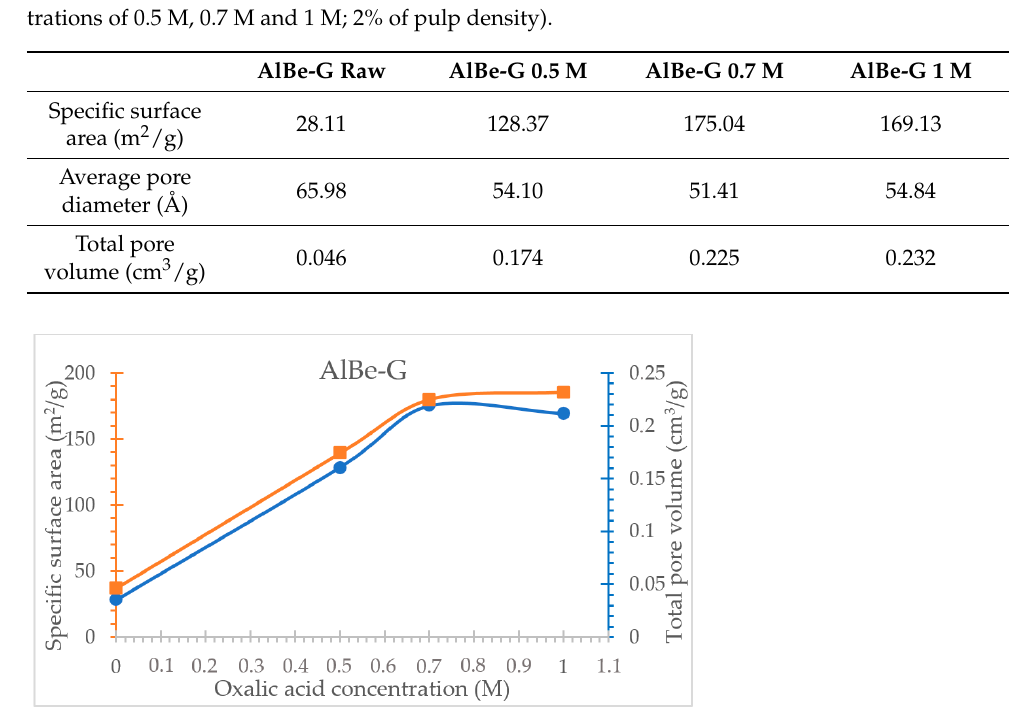
Figure 5. Specific surface area and total pore volume diagram of raw (labelled as “0” in the horizontal axis) and treated AlBe-G bentonite (80 °C; acid concentrations of 0.5 M, 0.7 M and 1 M; 2% of pulp density).